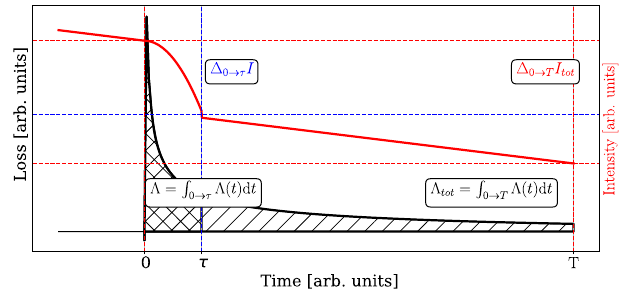
FIG. 7. Illustrative sketch for the algorithm used to compute the intensity lost ( Δ I ) due to the jaw movement ( 0 → τ ) using the total loss ( Λ ) decay phase (integral over 0 → T). tot